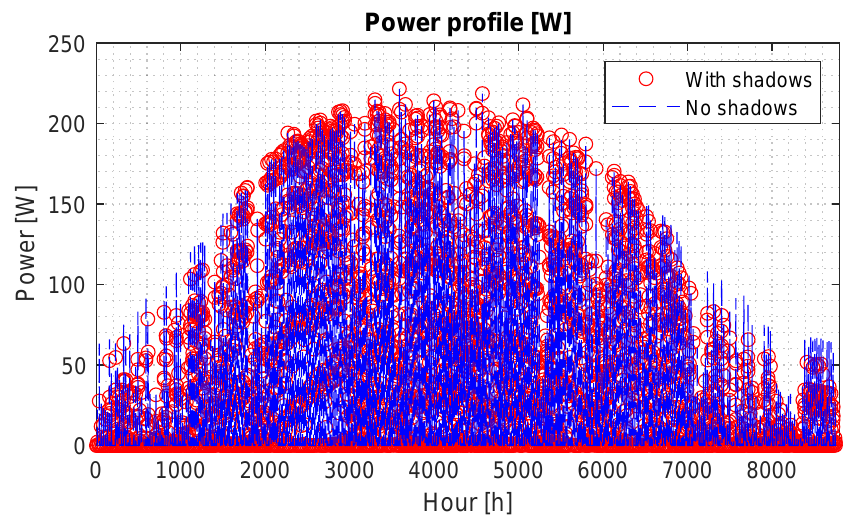
Figure 13. Annual power